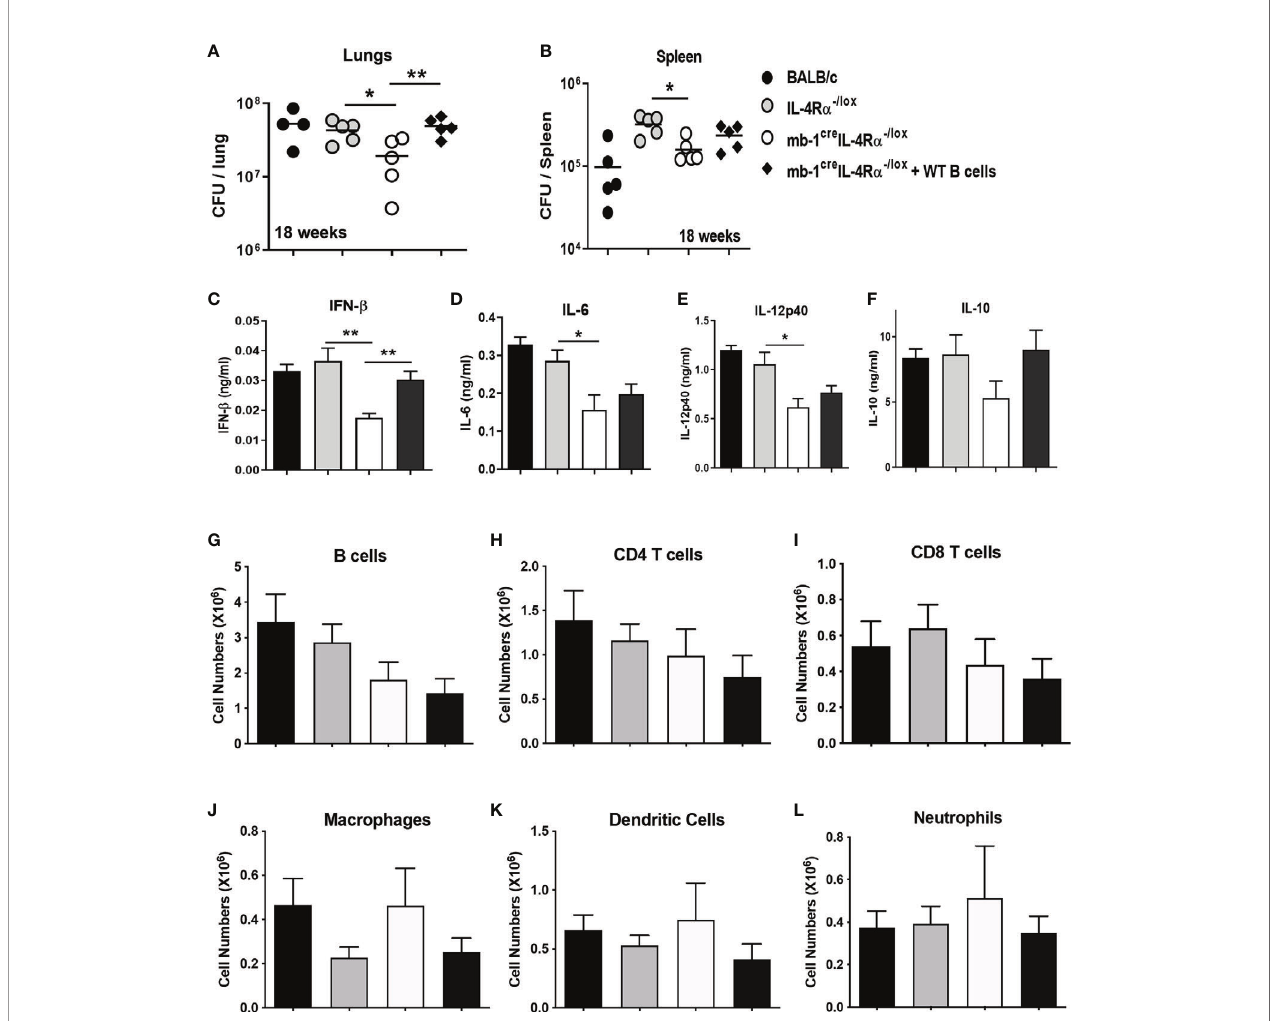
FIGURE 2 | Adoptive transfer of WT B cells intratracheally restored the bacterial burdens in B cell-speci fi c IL-4R a de fi cient mice during Mtb infection. Wild-type (BALB/c), littermate controls (IL-4R a -/lox ), B cell-speci fi c IL-4R a de fi cient mice (mb1 cre IL-4R a -/lox ) and adoptively transferred B cells in mb1 cre IL-4R a -/lox mice (mb1 cre IL-4R a -/lox + WT B cells) were infected intranasally with a 375CFU of H37Rv. (A, B) Bacterial burdens in the lungs and spleen after 18 weeks post-infection. (C – F) Lung homogenates were analysed for the cytokine responses such as for (C) IFN- b , (D) IL-6, (E) IL-12p40 and (F) IL-10 cytokine production by ELISA. Single cell suspension of lung cells was analysed for lymphoid (G – I) and myeloid (J – L) immune cell populations by fl ow cytometry. Cells were identi fi ed using the markers in parathesis; B cells (CD19 + CD3 - ), CD4 T cells (CD3 + CD4 + ), CD8 T cells (CD3 + CD8 + ), dendritic cells (CD11c + CD11b - MHCII + ), macrophages (CD11b + CD11c - MHCII + ) and neutrophils (SiglecF - CD11c - Gr1 + ). Data are shown as mean ± SEM of n = 5 mice/group, representative of two independent experiments, analysed by unpaired, student ’ s t-test versus littermate control, *p < 0.05 and **p <